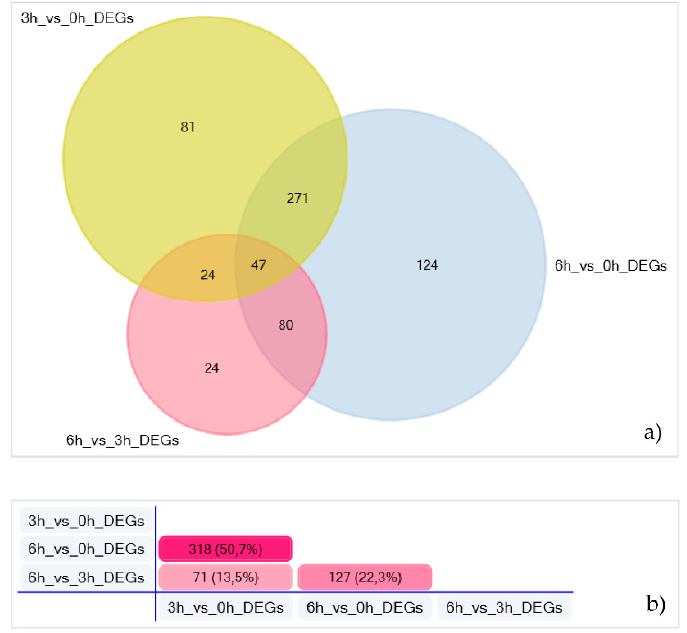
Figure 3. Angiogenesis-related genes dysregulated in A2E-treated H-RPE cells. ( a ) The Venn diagram reports the number of angiogenesis-related DEGs, for each time point (intersections). ( b ) Pair- comparison highlighting the percentage of DEGs between time-point pairs.